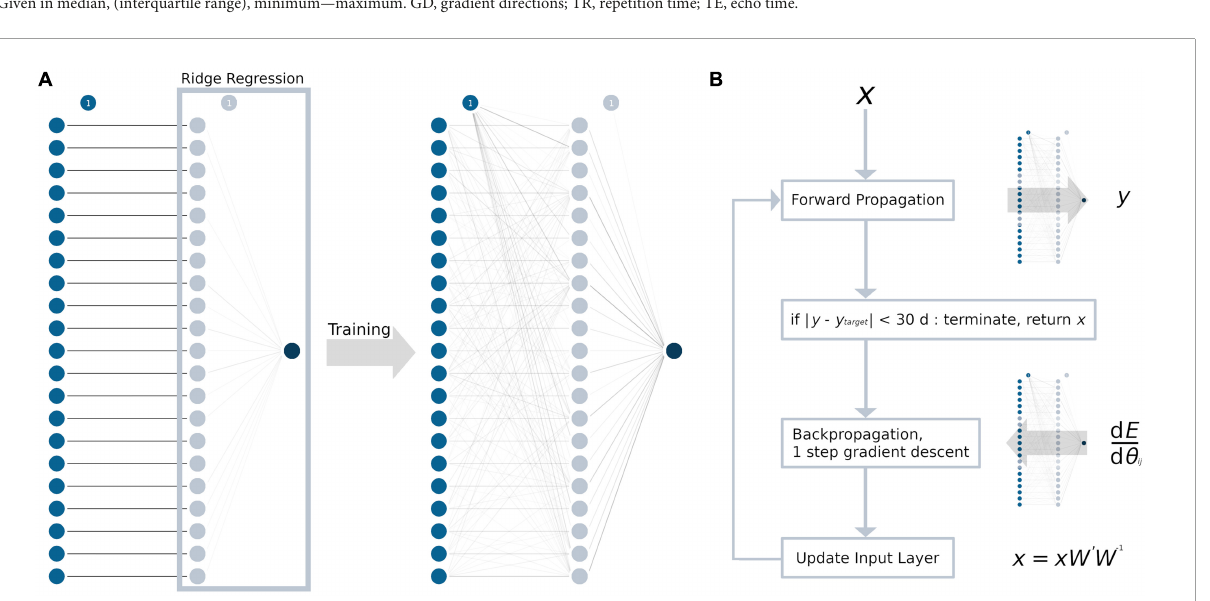
FIGURE1 Development of the ANN and the ANN age-correction algorithm. Circles represent neurons, the bias unit is marked with “1.” For every tract system (input layer, blue), there is exactly one neuron in the hidden layer (light blue). Weights are displayed as lines in grayscale, with 0 as white and 1 as black. (A) The weights between the input and the hidden layer were initialized as the identity matrix. The weights between hidden layer and the output layer (dark blue) were initialized as the coefficients from the ridge regression (light blue box). After training, the hidden layer processes multiple interactions from the input layer, which are represented by gray lines. (B) ANN age correction algorithm: First, the input data x were forward propagated through the ANN with the weight matrix W , resulting in the brain age prediction y . Then, the difference between y and the age correction target y target (= error E ) was backpropagated to calculate the modified weight matrix W’ . Forward and backpropagation are identical to a regular gradient descent algorithm which are commonly used for ANN training. Last, the input data x were updated by matrix multiplication ( xW’W - 1 ). These steps were repeated until the error E reached an absolute value of 1 month or less and the algorithm terminated. d E /d θ ij = partial derivatives of the error with respect to the weights in the weight matrix W